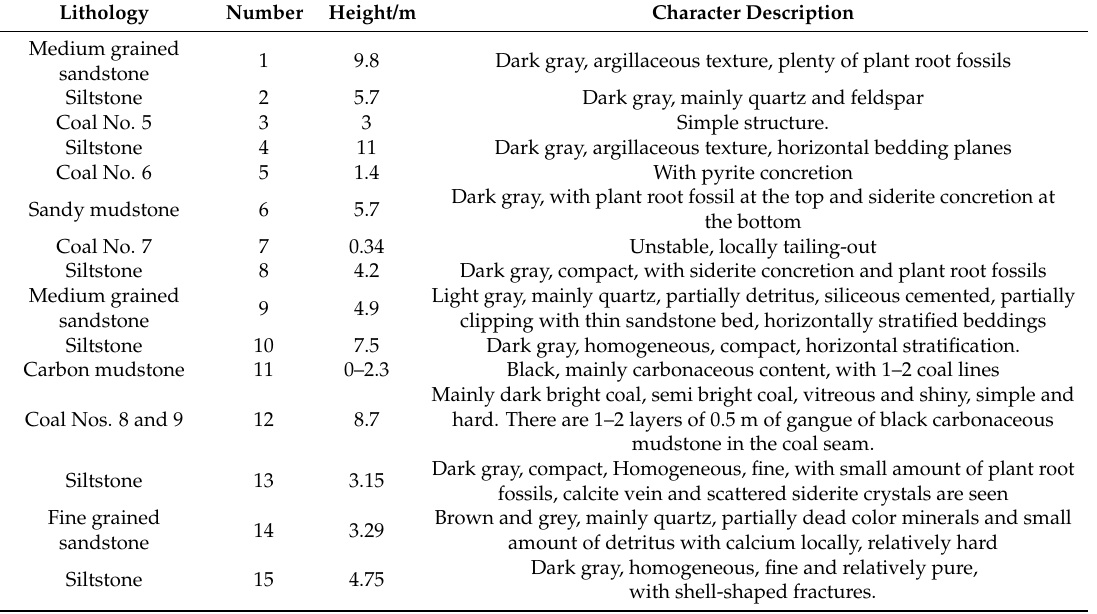
Table 1. Characteristics of the coal seam and surrounding rock